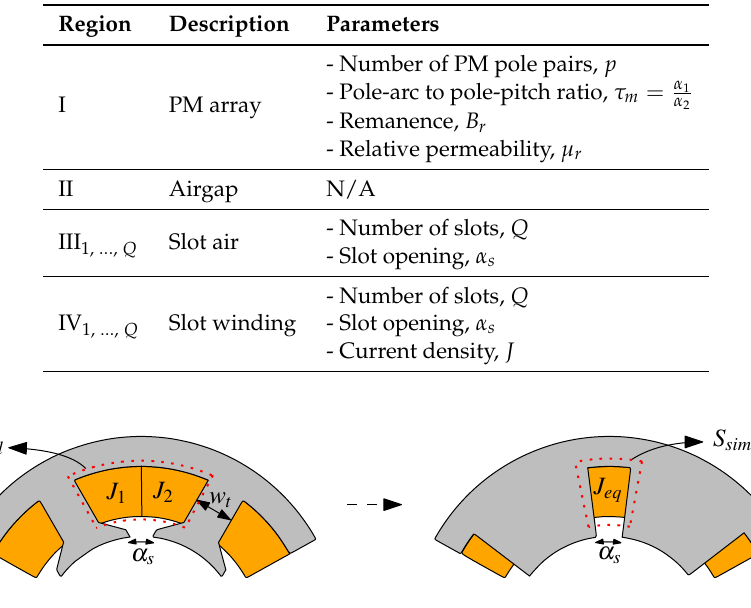
Figure 5. Slot winding region